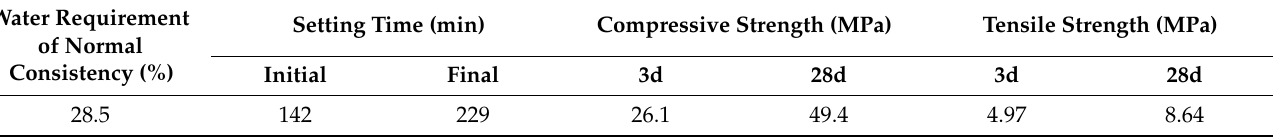
Table 2. Physical and mechanical properties of cement.